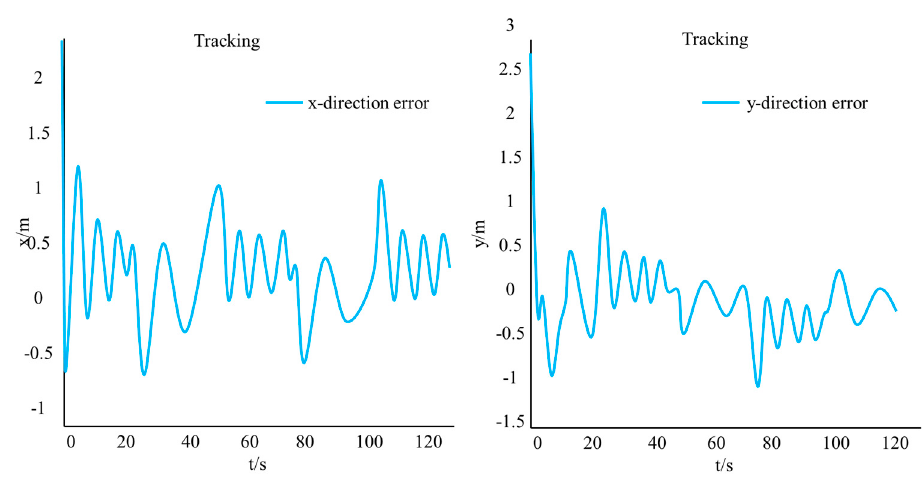
Figure 10. x , y , and θ axis trajectory tracking error.